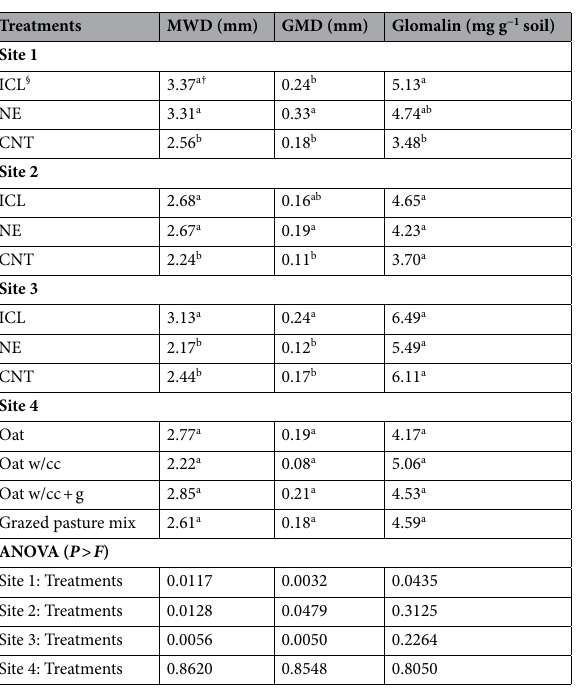
Table 2. Mean weight diameter (MWD), geometric mean diameter (GMD), and glomalin at 0–5 cm soil depth as influenced by different production systems at sites 1, 2, 3, and 4. § ICL integrated crop–livestock, NE natural ecosystem, CNT control, CC cover crop, g grazing. † Means followed by different letters within a column under each site are significantly different at P ≤ 0.05 according to Fisher’s LSD.